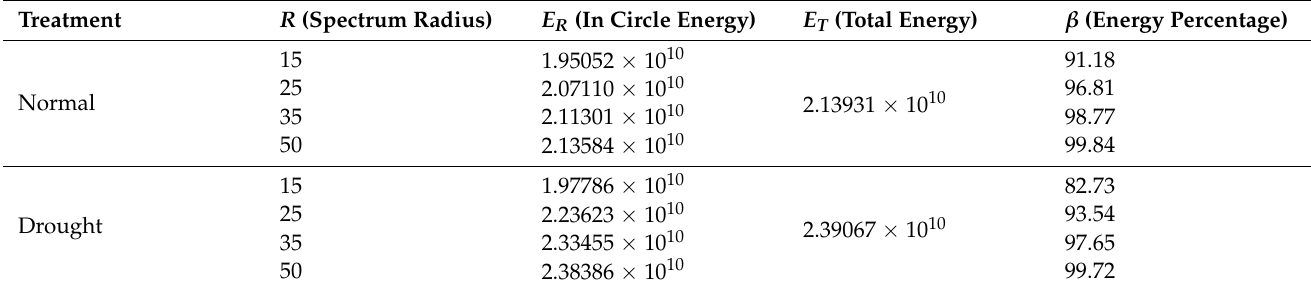
Table 5. Spectrum energy distribution of the soybean canopy in the NIR